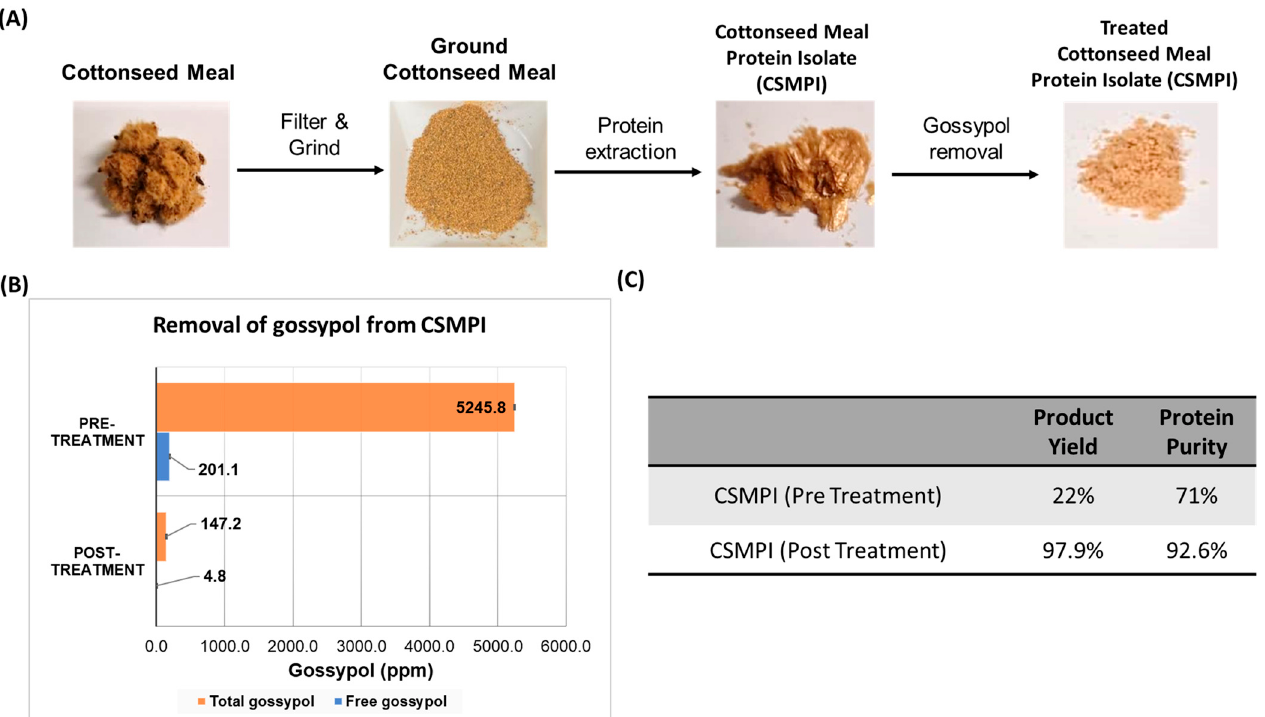
Figure 1. An overview of the CSMPI production process. ( A ) The general workflow of the protein extraction process to obtain CSMPI with ultra-low gossypol content from raw CSM. ( B ) Comparison of free and total gossypol between the pre-treated and post-treated CSMPI. ( C ) The product yield and protein purity of the pre-treated CSMPI and post-treated CSMPI.